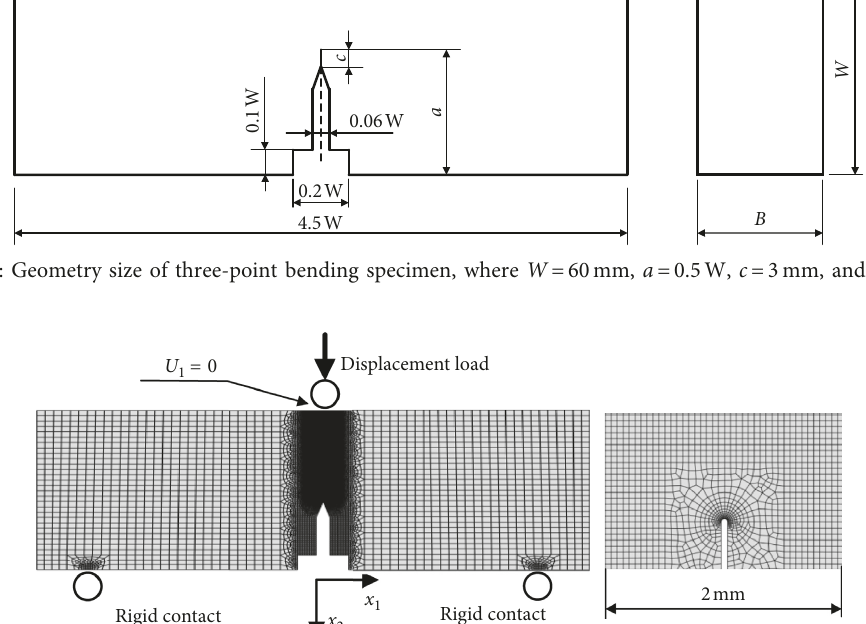
Rigid contact Figure 4: Mesh, load, and boundary condition of the specimen: (a) the global mesh model and (b) the mesh of crack